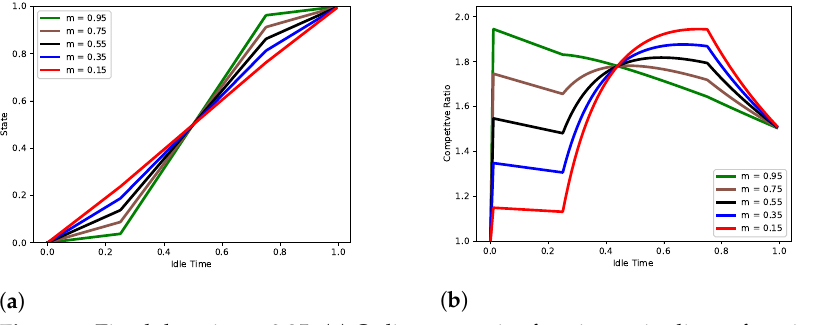
Figure 9. Fixed duration = 0.25. ( a ) Online strategies for piece-wise linear functions, linear system, ( b ) competitive ratios for piece-wise linear functions, linear